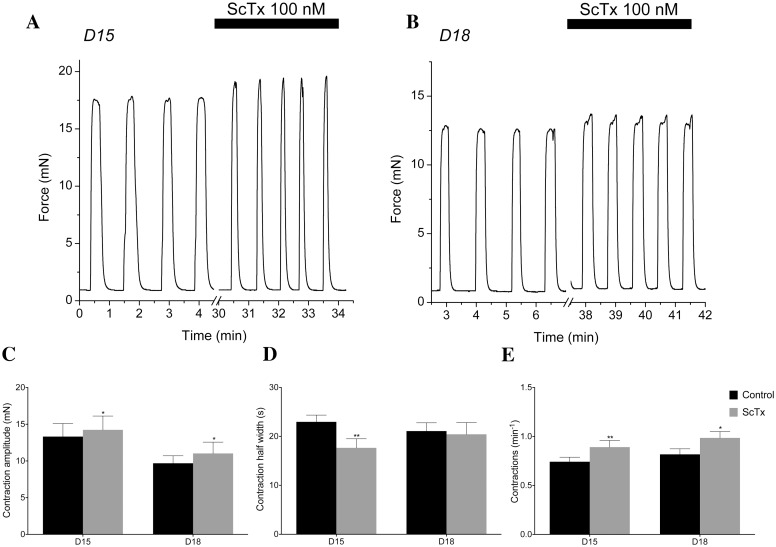
Kv2.1 contribution to spontaneous contractile activity.(A, B) Representative isometric force recordings in the presence of 100 nM ScTx in D15 (A) and D18 (B). (C) ScTx significantly increases contraction amplitude in both D15 murine myometrium from 13.32±1.79 mN to 14.24±1.87 mN and in D18 from 9.69±1.79 mN to 11.02 ± 1.87 mN. (D) ScTx significantly decreases contraction half width in D15 from 22.97±1.38s to 17.65±1.86s, while contraction half width in D18 tissue remained unchanged. (E) Effect of ScTx on contraction frequency for D15 & D18 murine myometrium. ScTx significantly increased contraction frequency for D15 & D18 murine myometrium from 0.74±0.05 to 0.89±0.07 contractions per minute and in D18 from 0.82±0.06 to 0.99±0.07 contractions per minute (p ≤0.01, n = 7).